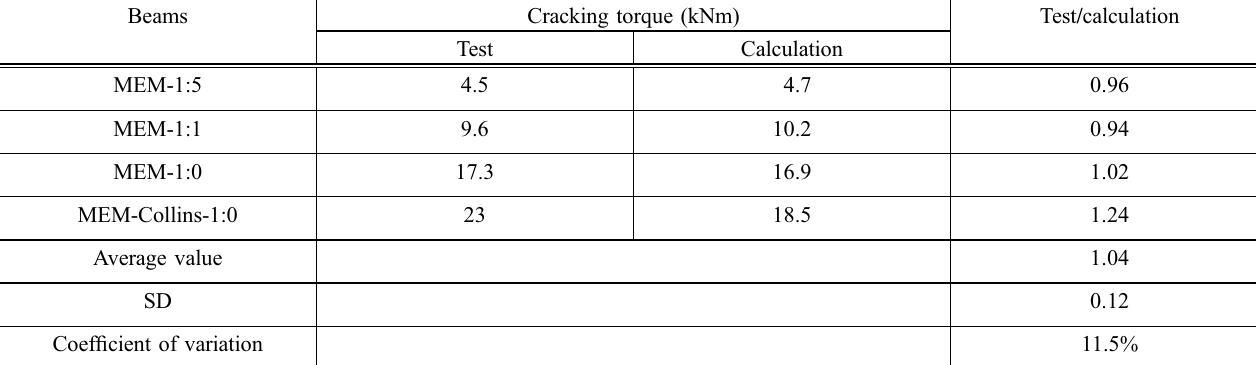
Table 4 Comparison of test cracking torque and calculated cracking